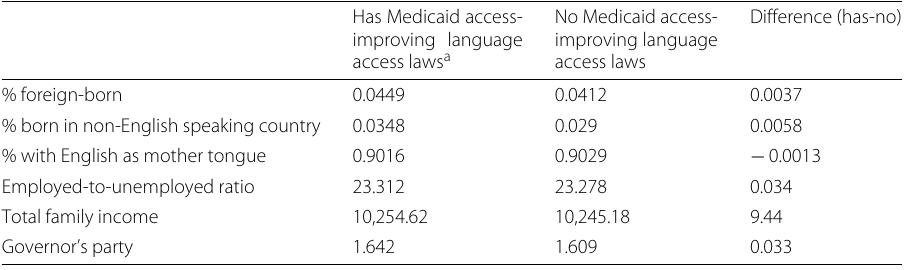
Table 1 1970 characteristics